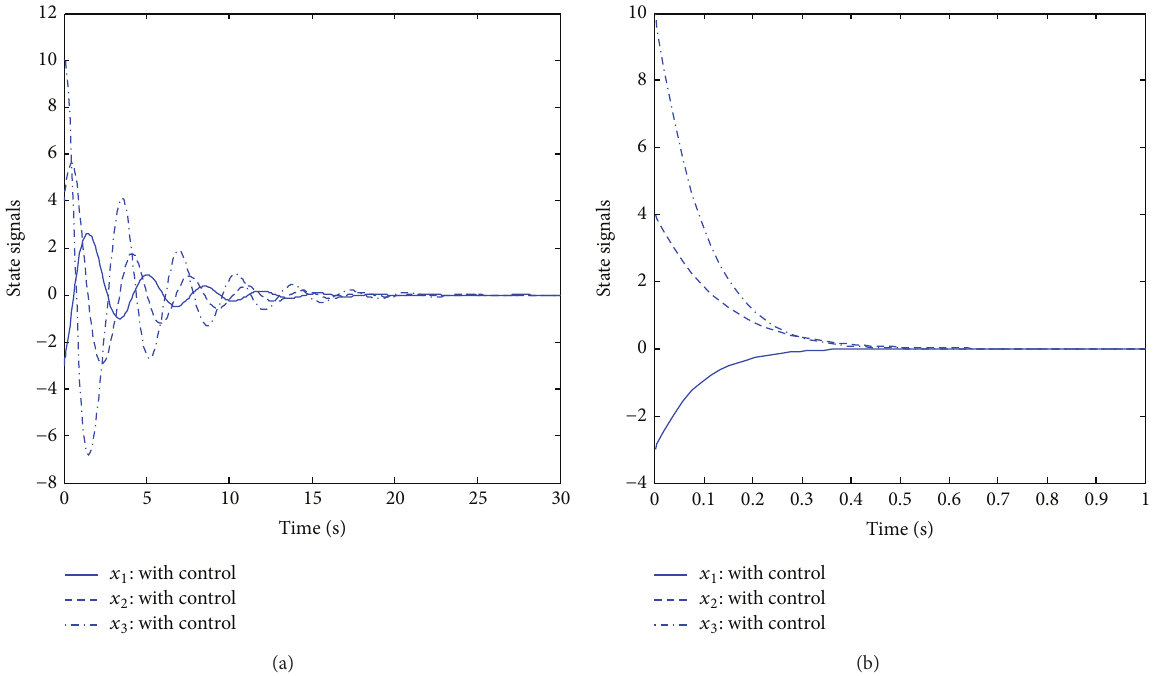
Figure 5: Transient response of state signals with (a) single input, single state, unit negative feedback 𝑢 2 = −𝑥 2 ; (b) static state feedback 𝑢 = 𝐾𝑥 , 𝐾 = diag (−10 −10 −10) .